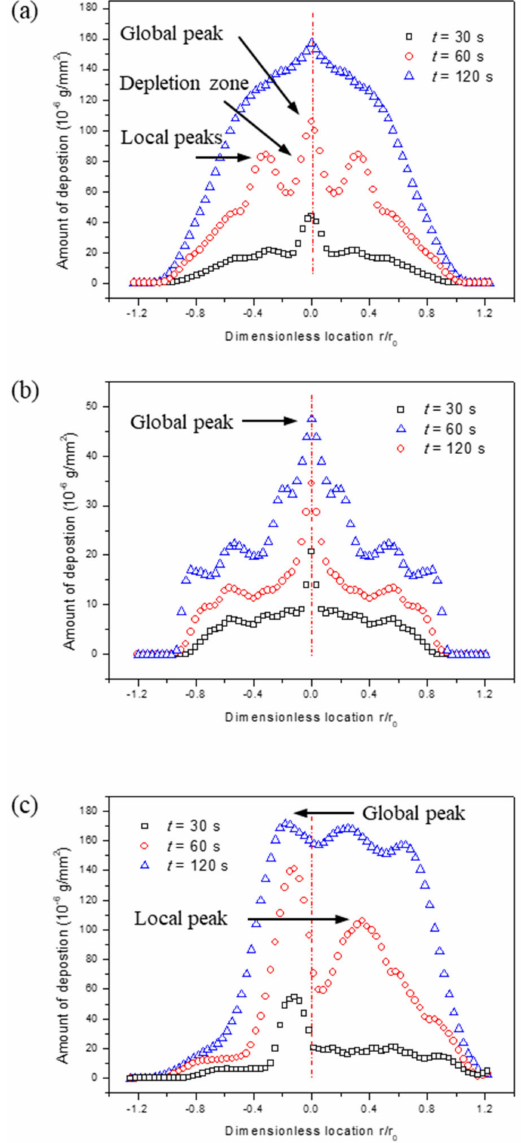
Figure 5. Variation of the amount of deposition against the contact radius for the cases of a horizon- tally ( a ), inverted ( b ), and vertically ( c ) orientated substrate, respectively. r 0 is the contact radius. Each group of data is computed based on 12 − 14 individual